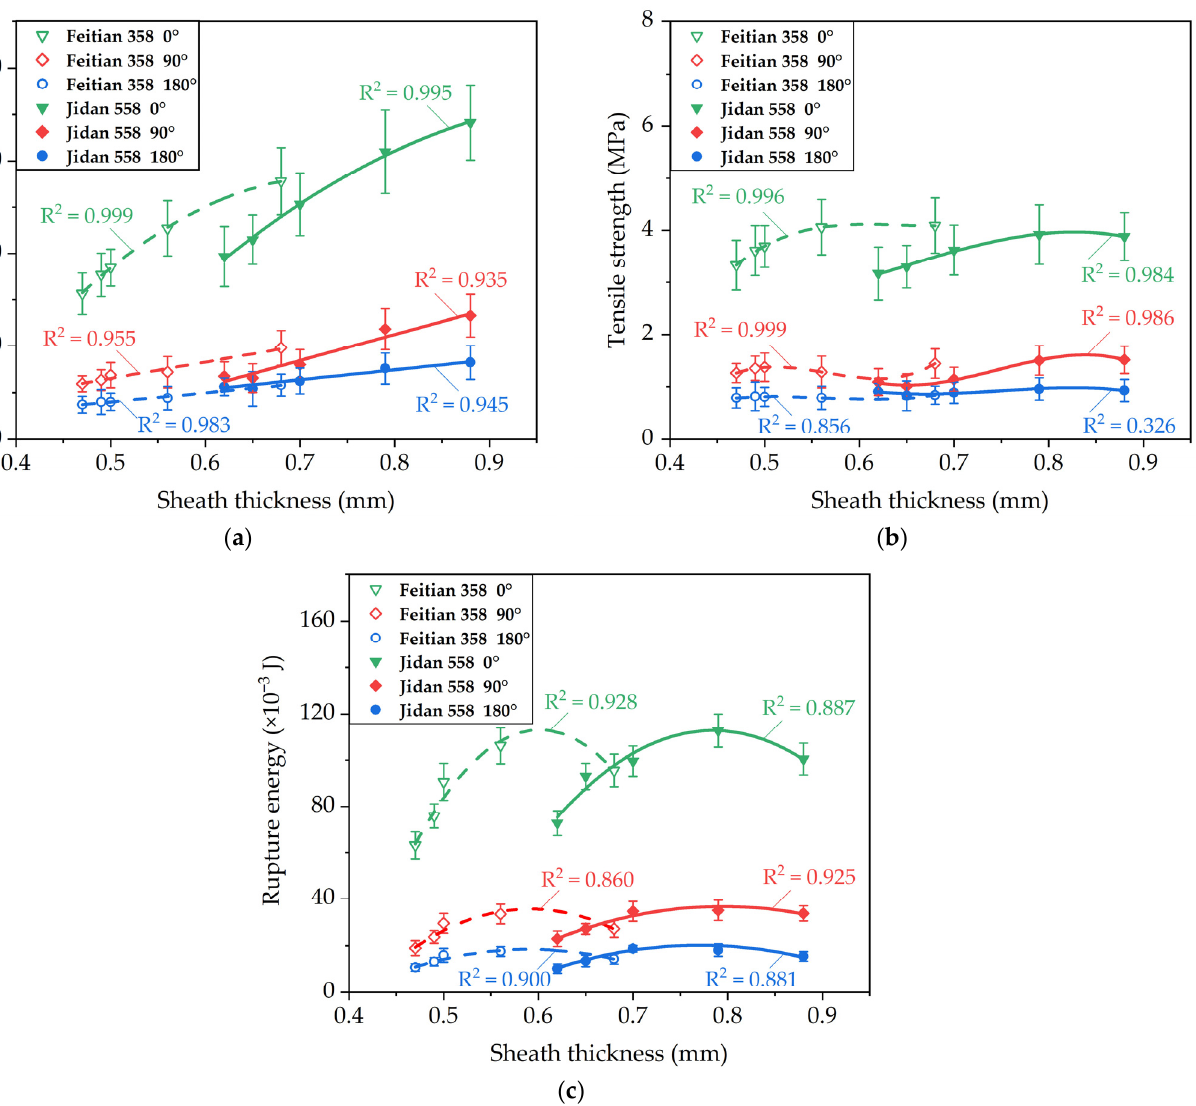
Figure 6. Relationships between tensile properties and sheath thickness: ( a ) fracture force; ( b ) tensile strength; ( c ) fracture energy.